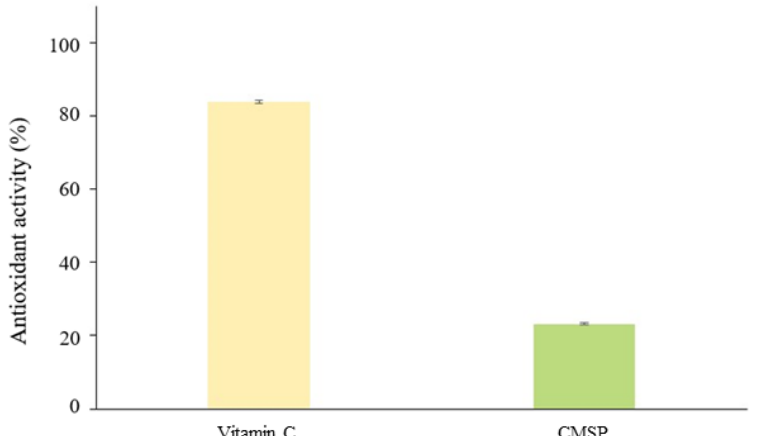
Figure 5. Antioxidant activity of the CMSP in relation to the standard, vitamin C, measured at 20 mg/mL.